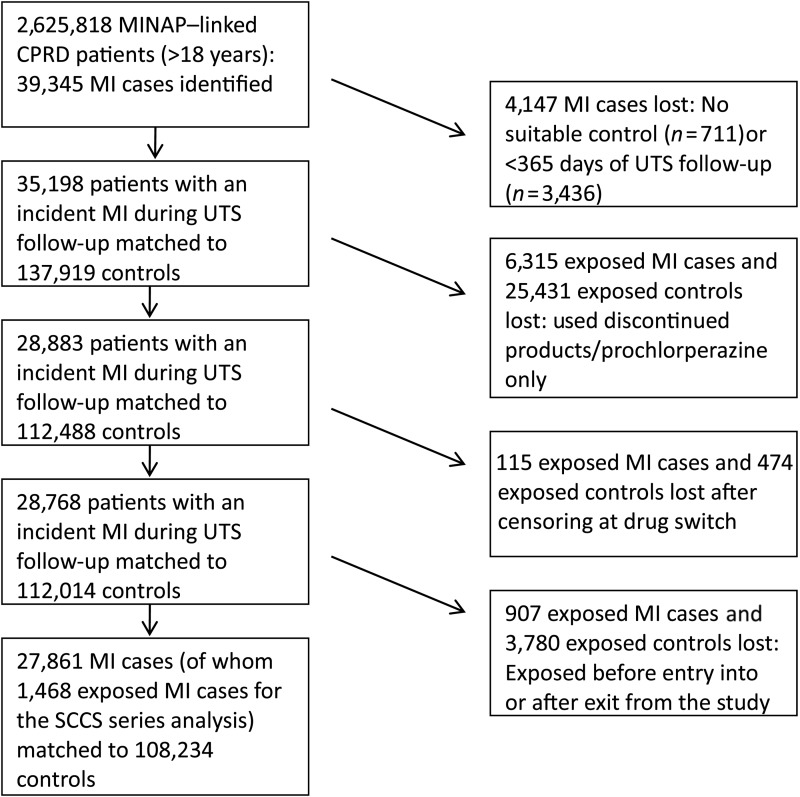
Flow diagram showing patient population for the case–control study ‘myocardial infarction and antipsychotics’.